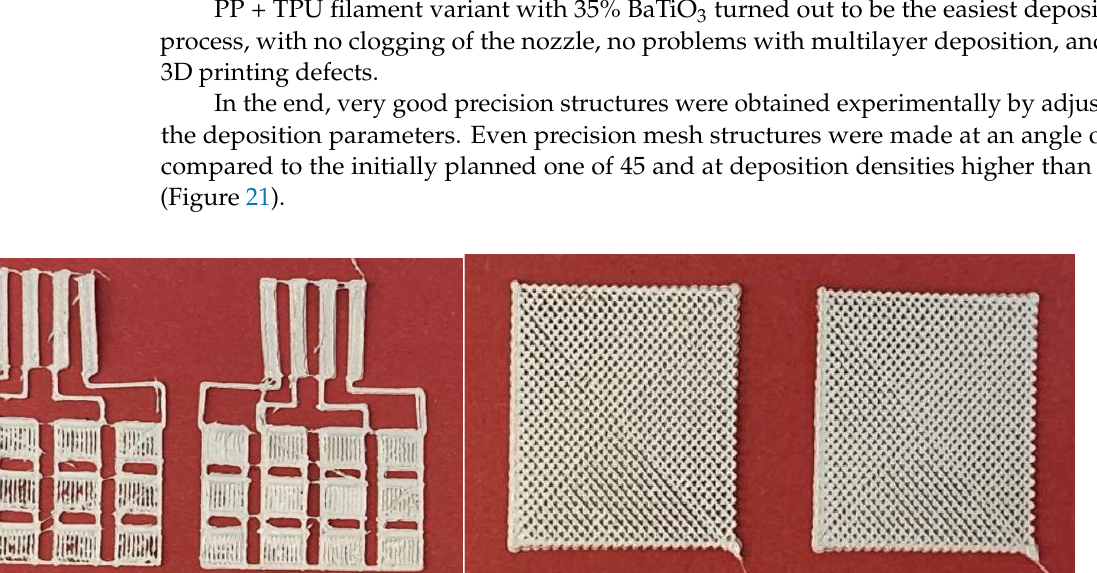
Figure 20. Setting the parameters of the laboratory 3D thermal printer.